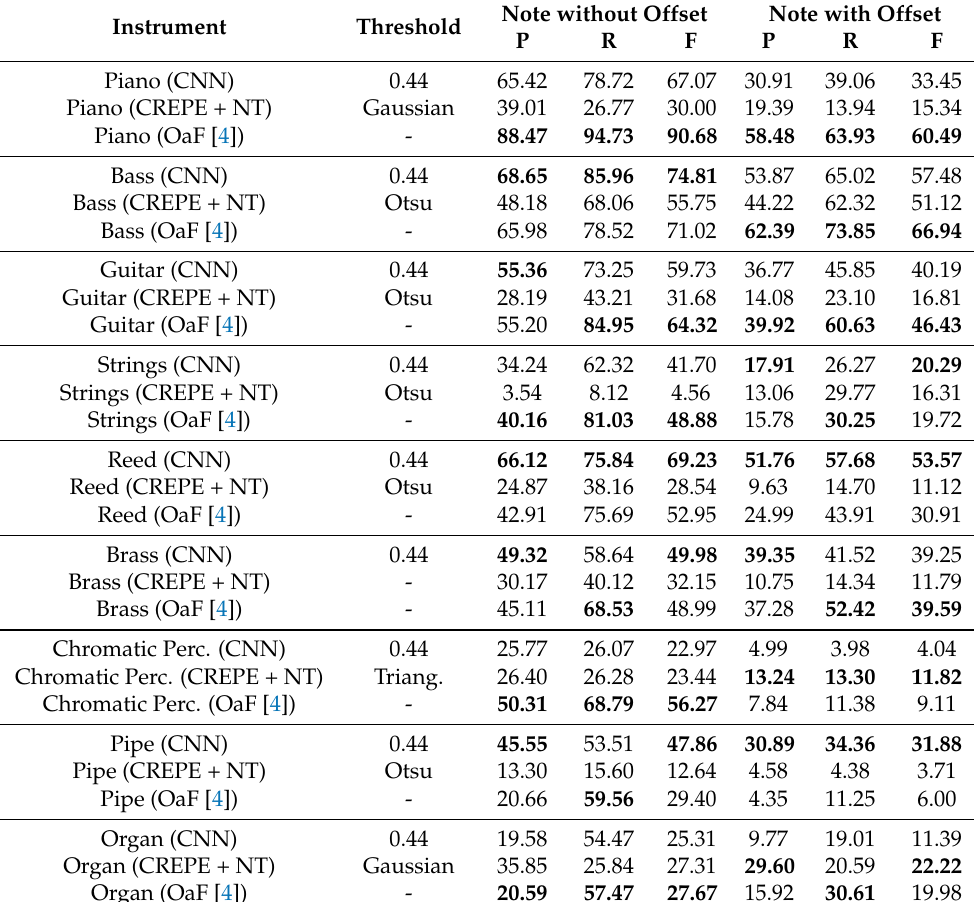
Table 3. Transcription metrics of our first model (CREPE + NT) which is monophonic and our second model (CNN) which is polyphonic, and OaF test with Slakh2100 dataset. Best result for every metric is highlighted in